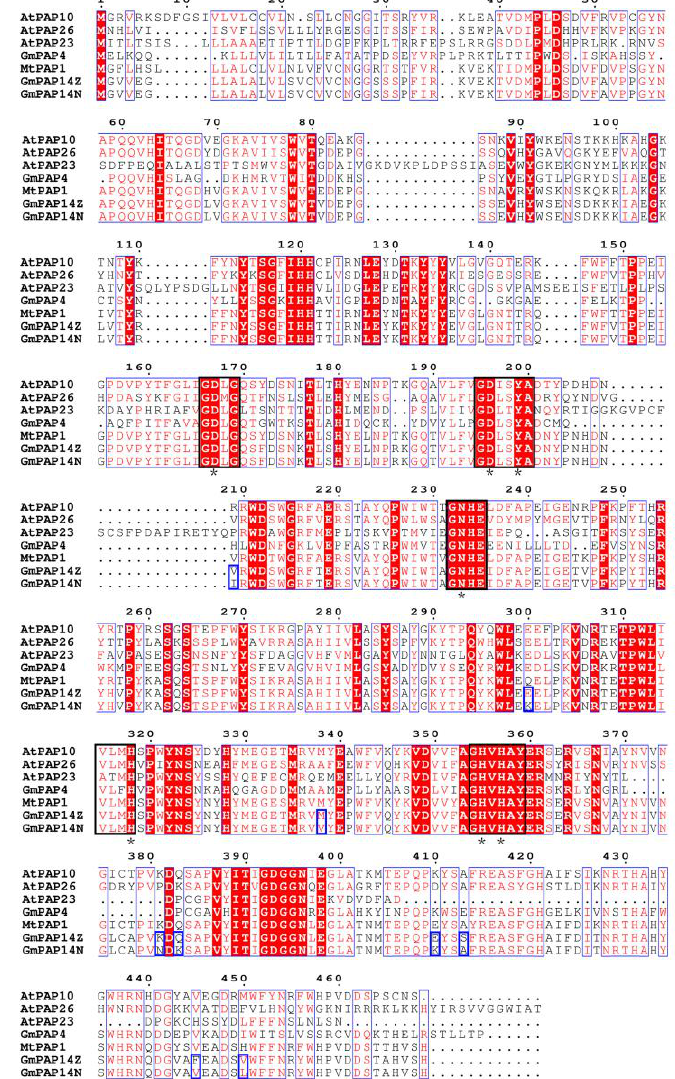
Figure 4. Amino acid sequence alignment of GmPAP14 and other PAPs. GmPAP14Z represents GmPAP14 protein in ZH15 and GmPAP14N represents GmPAP14 protein in NMH. Conserved motifs are indicated by black boxes. Conserved activity sites are indicated by asterisks. The variants of amino acid residues between GmPAP14Z and GmPAP14N are indicated by dark blue boxes. Protein alignment was performed by MEGA X and modified by ESPript3.0.